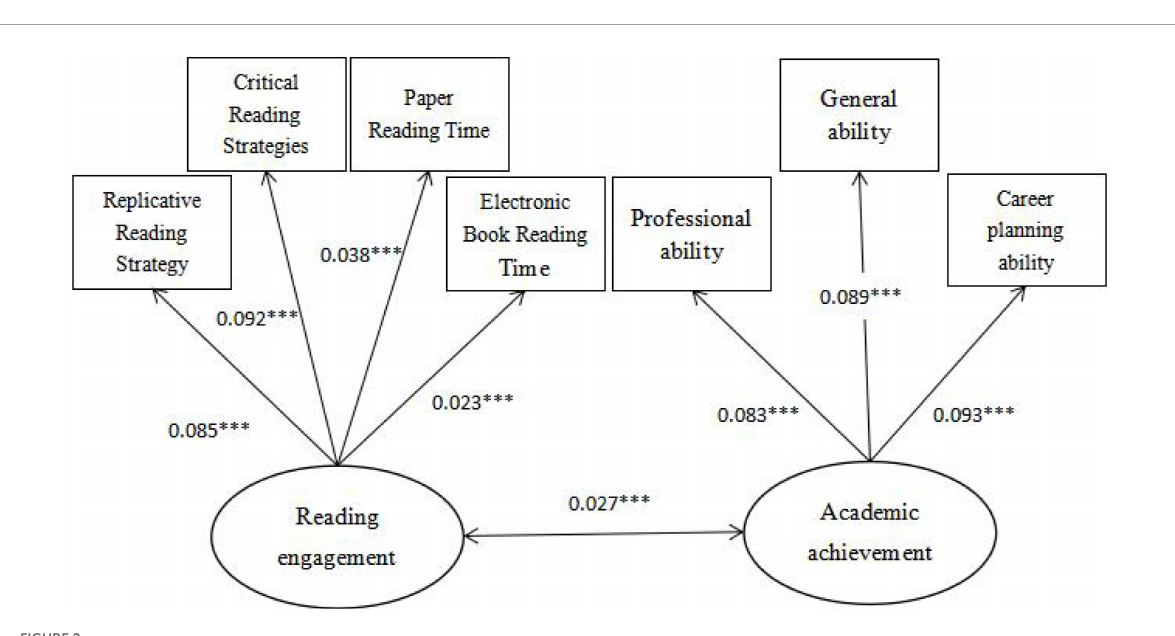
indicators are consistent, indicating that the validity of reading engagement in the questionnaire is